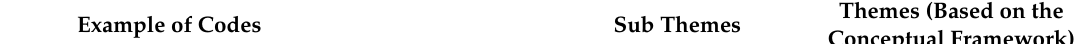
Table 2. Codes, subthemes and themes used in data